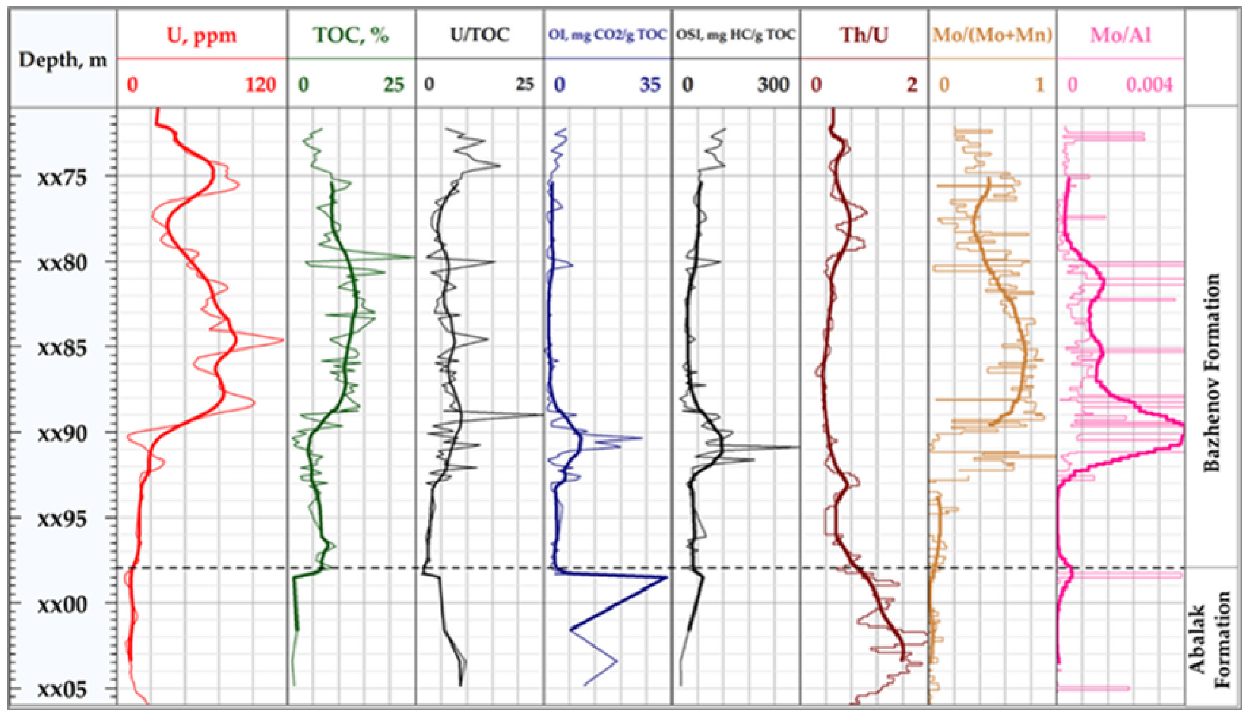
Figure 3. Logview well 2: U, Th/U, TOC (total organic carbon), OI (oxygen index), OSI (oil saturation index), U/TOC, Mo/Al, and Mo/(Mo + Mn).